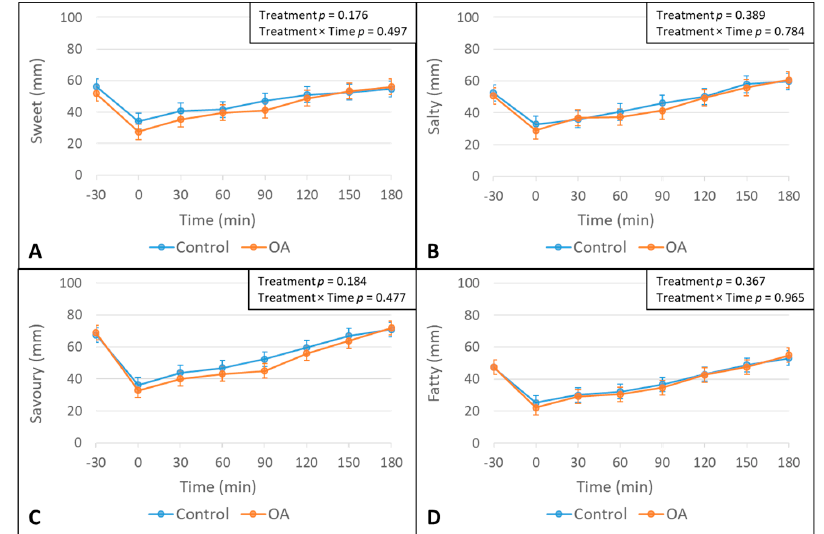
Figure 4. Means and SE bars for self ‐ reported desire to eat foods with specific taste ratings in participants ( n = 31) prior to and following mouth rinse treatments over time. Means, SE bars, and p ‐ values were estimated by using a linear mixed model including treatment, time, and treatment × time interaction as fixed effects; the participant was used as a mixed effect to control for duplicate measures of each treatment. ( A ) Desire to Eat Sweet Food ratings; ( B ) Desire to eat Salty Food ratings; ( C ) desire to eat savory food ratings; and ( D ) desire to eat fatty food